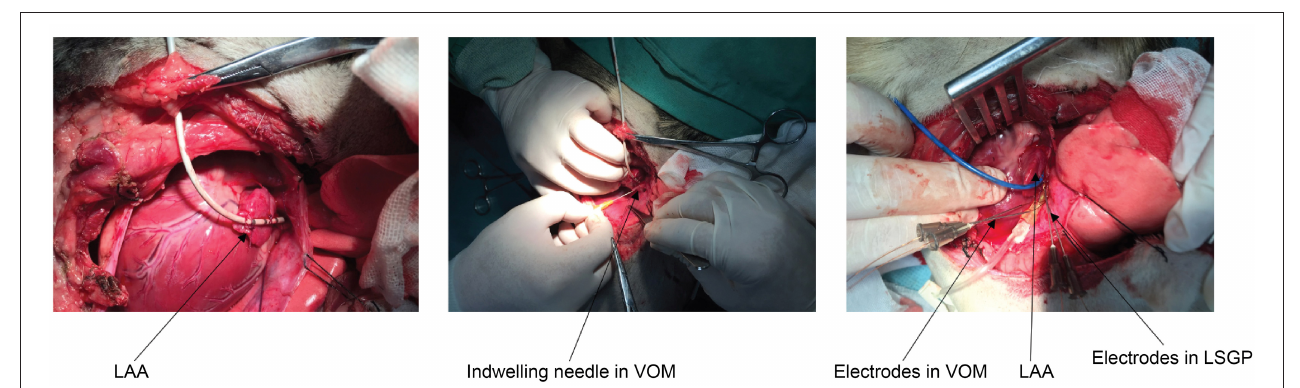
FIGURE 2 | Anatomical location and catheter positioning. LAA, left atrial appendage; VOM, vein of Marshall; LSGP, left superior ganglionated